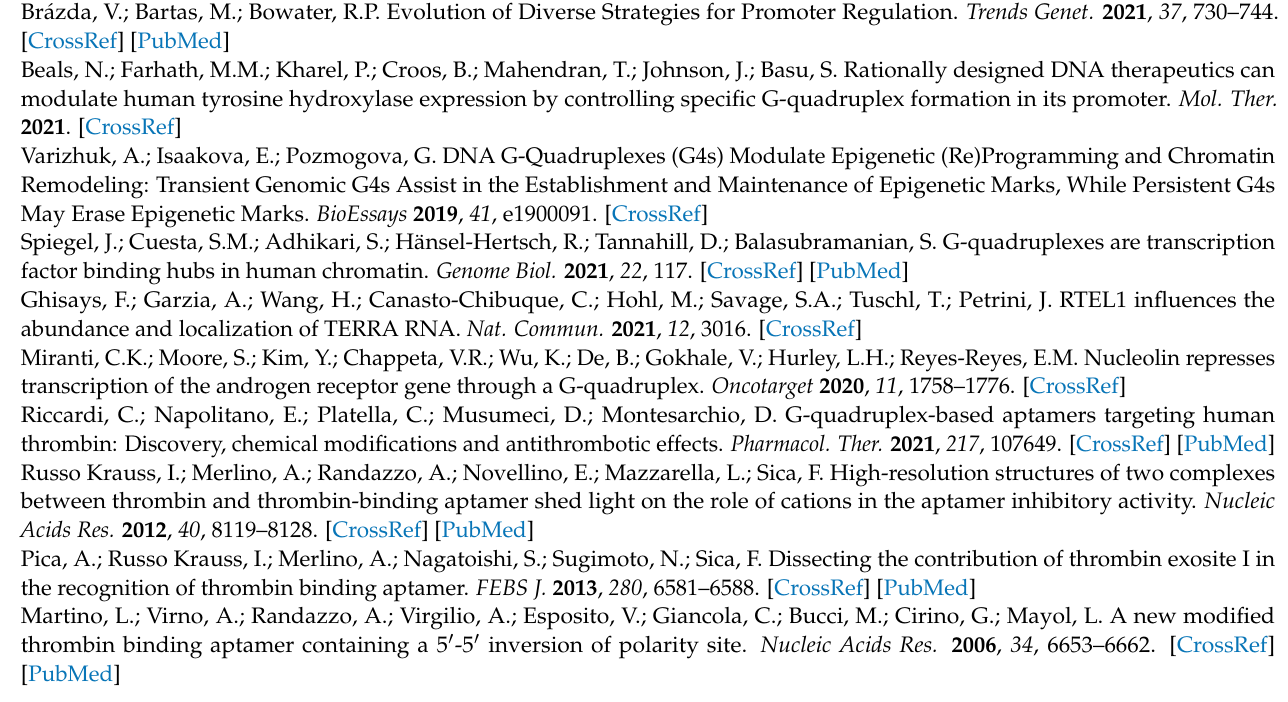
Figure S8: UV melting profiles of the modified variants TBA2 α , 3Q4 α , 3Q, and 3Q-ppg at 295 nm Figure S9: CD spectra of the aptamer 3Q-ppg at 20 ◦ C. Figure S10: Normalized clotting